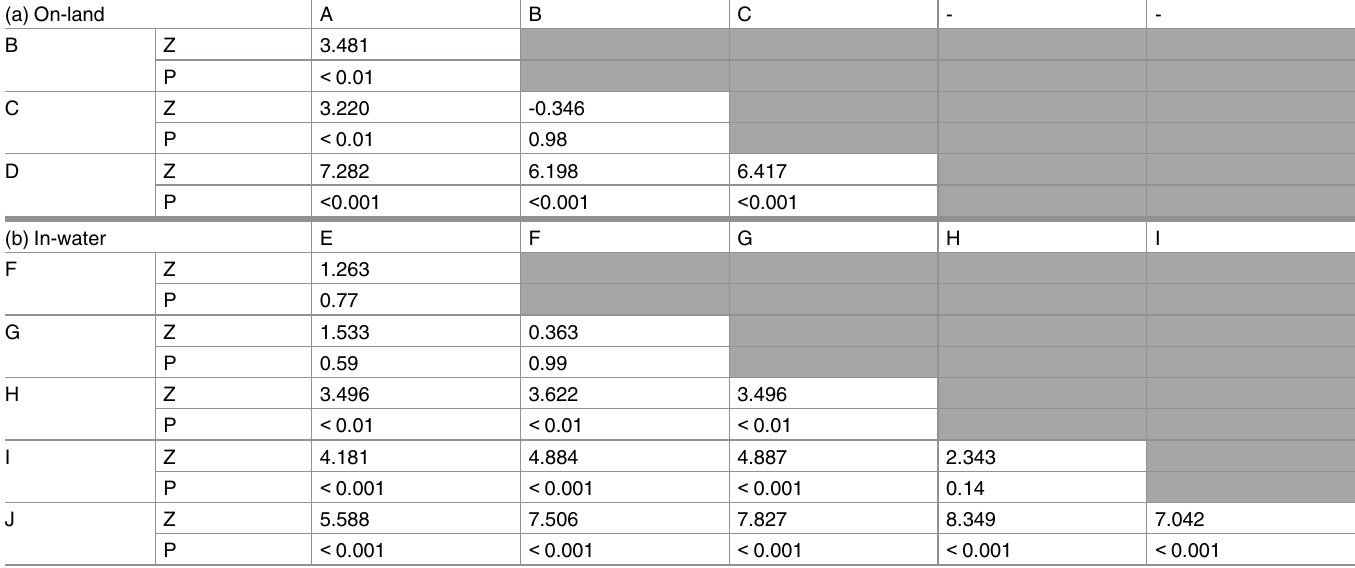
Table 1. Results of simultaneous tests for general linear hypotheses of variation in visitor abundance among sections of Akumal Bay, Mexico. Shownare Z and P values respectively for post-hoc pairwise comparisons betweenbay sections: (a) on land duringpeak use at 14:00 each day in 4 sections (A-D), and (b) in the water during peak use at 16:00 each day in 6 sections (E-J). (a) On-land